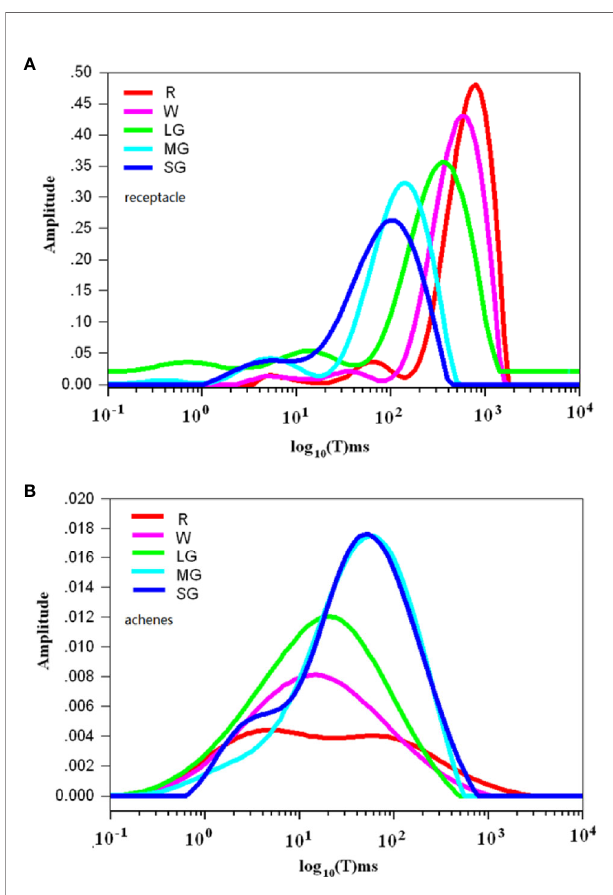
FIGURE 3 | Changes in water mobility during fruit development and ripening as detected by nuclear magnetic resonance (NMR) analysis. (A) Spectra showing water mobility status in the receptacles. (B) Spectra showing water mobility status in the achenes. The signal amplitude on the Y axis signi fi es the relative amount of water and the relaxation time on the X axis signi fi es water mobility. SG, small green; MG, middle green; LG, large green; W, white; and FR, full reddening. Spectral values are the means of hour biological